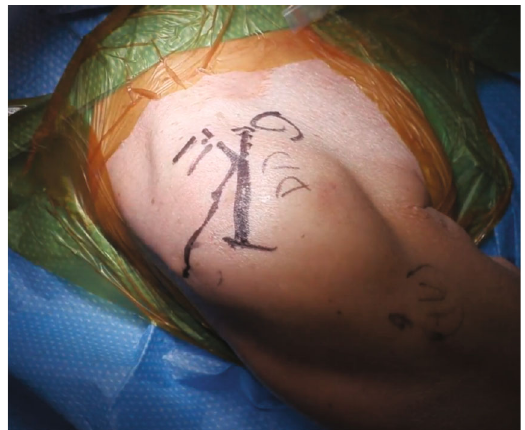
Figure 2: With the patient in a beach chair position, the defect of the torn right deltoid muscle is visible just distal to the antero- lateral aspect of the